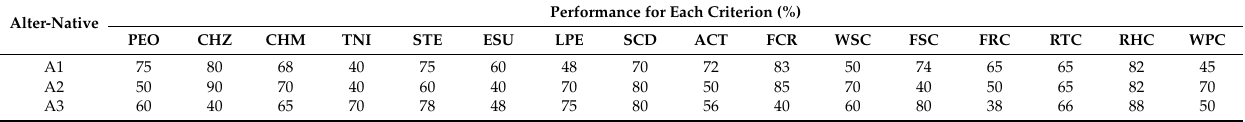
Table 8. Performance of each criterion in each alternative.